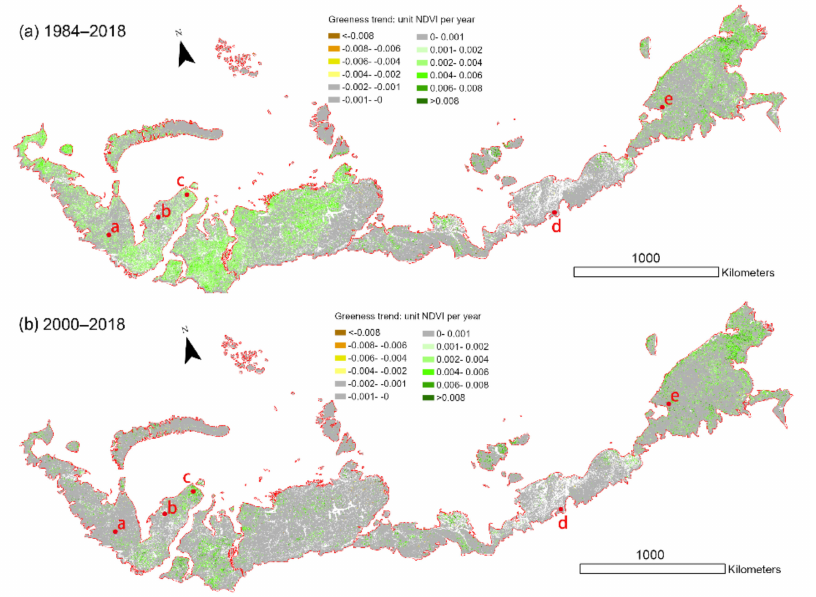
Figure 4. The greenness trend maps based on Landsat data: ( a ) the greenness trend values from 1984 to 2018; ( b ) the greenness trend values from 2000 to 2018.